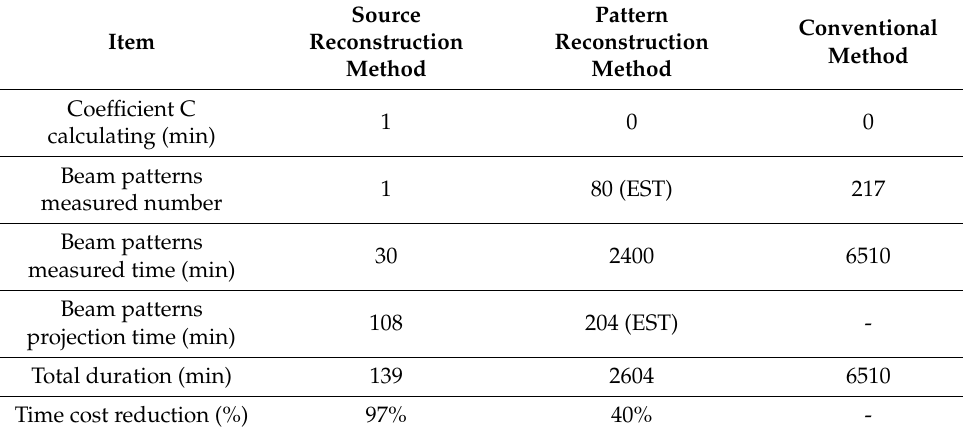
Table 4. Efficiency comparison of different